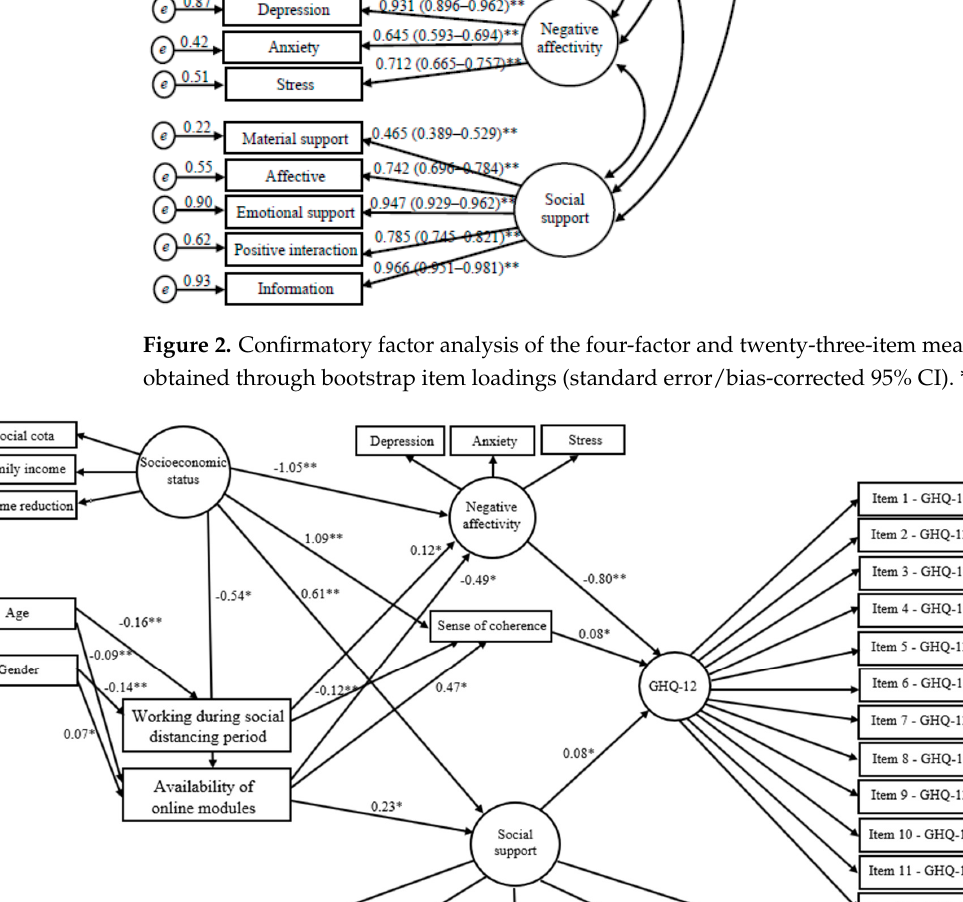
Figure 3. Direct effects showing the standardized estimates for the parsimonious model. * p < 0.05, ** p < 0.01.